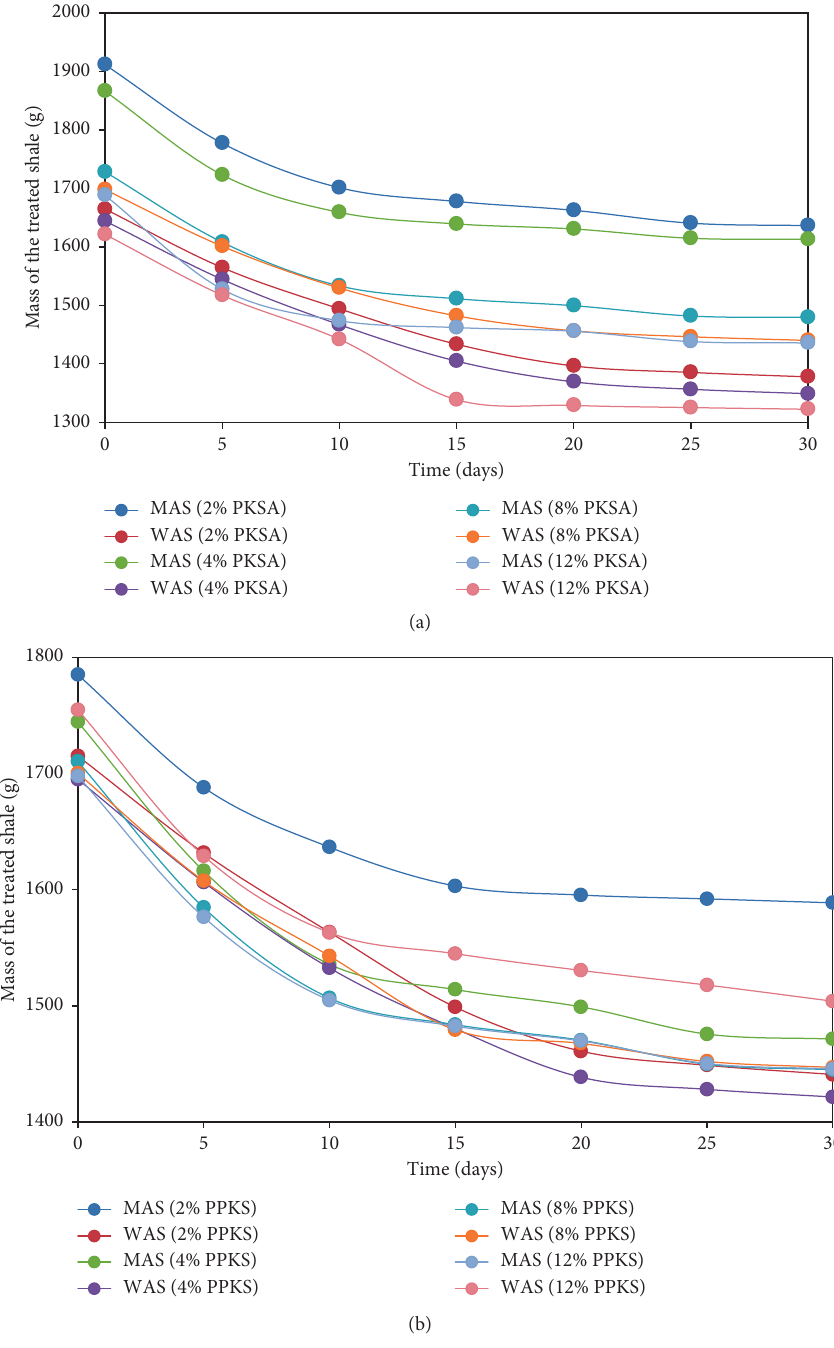
Figure 11: Relationship between the mass of the treated shale and